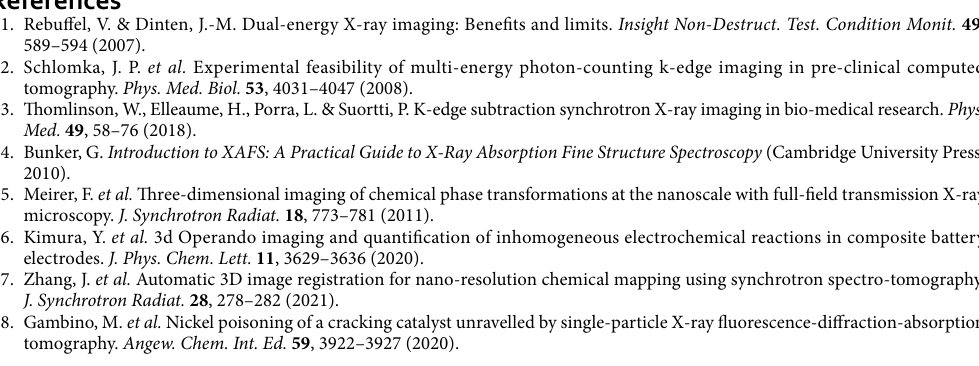
Se compound was measured so that the absorption coefficient above the Se K absorption edge was µ x ≈ 1 . With 2 mm of unfilled margin left for each hole, in terms of sample mass this corresponds to approx. 0.7 mg of elemental Se. The filled holes were capped with tissue paper. The projections of the phantom were acquired at four different photon energies near Se K-edge: 12.645 (A), 12.658 (B), 12.662 (C), and 12.685 (D) keV. The energies were chosen so that A was well below all the absorption edges of Se compounds, B was above the white line of Se(0) but below that of Se(IV), C was above the white line of Se(IV) but below that of Se(VI), and D was well above all the absorption edges. The relationship between the acquisition energies and the absorption spectra are presented in Fig. 3 ◦ ◦ At each photon energy 200 projections were acquired over 360 rotation of the sample at 1.8 intervals. Each projection were exposed for 100 s. Before and after the acquisition of the projections 2 flat field images were recorded without the sample for 1000 s each. Due to extremely low background noise of the detector, no dark field images were taken. Si(953) analyser was used as a monochromator and the acceleration voltage and current of the X-ray tube were 20 kV and 40 mA, respectively. With this combination of acceleration voltage and crystal reflection only the lowest order diffraction peak is present. The mean primary source to analyser distance was ◦ ◦ approx. 48.4 cm (Bragg angles 74.8 –75.5 ) and secondary source to detector distance was approx. 21 cm. Data processing. The data processing was performed with custom scripts written in Python 3 using mostly NumPy/SciPy libraries 26,27 . The reconstructions were performed using the radon transform implemented in scikit-image library 28 . The matrix inversion was performed using numpy.linalg.inv function. Figures 1 and 2 were made using Inkscape 1.1 (http:// inksc ape. org/). Figures 3, 4, 5, 6 and 7 and all the supplementary figures were plotted using Matplotlib 3.3.4 (http:// matpl otlib. org/) 29 . Figure 8 was made with 3D Slicer 4 (http:// www. slicer. org/) 22 . Additional labels were added to Figs. 3 and 8 with Inkscape 1.1. The data and the analysis macros